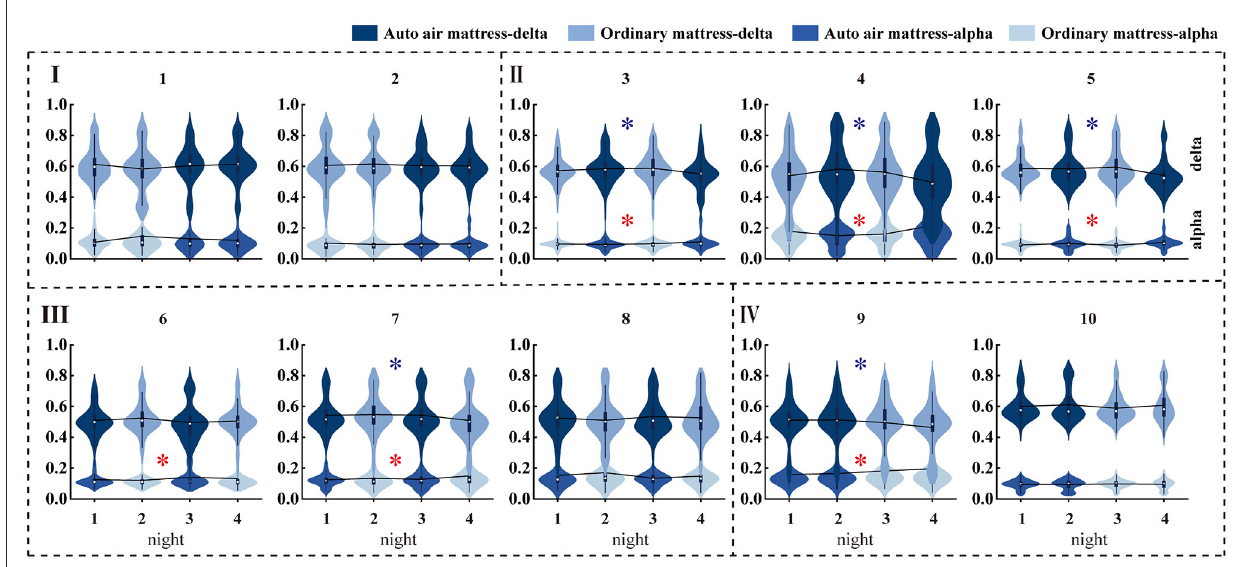
FIGURE5 The delta and alpha power distributions of each male participant throughout the night. Blue star and red star indicate that delta power significantly decreases and alpha power increases with the experimental nights, respectively.